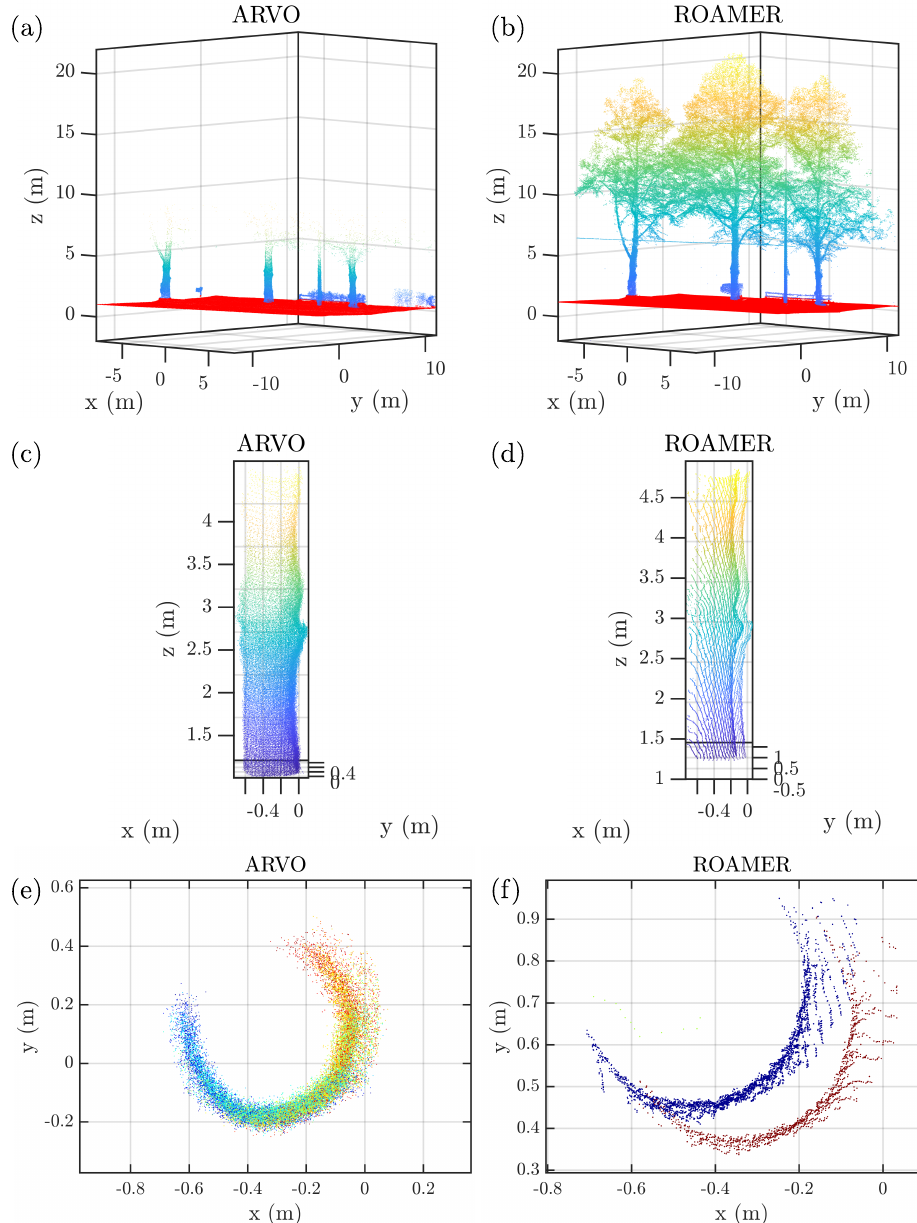
Figure 7. ( a , b ) A small section of the point cloud collected using ( a ) the ARVO system, and ( b ) the ROAMER system. The points are colored based on their z -coordinates, apart from the ground points that are denoted in red. ( c , d ) Close-up of an example tree trunk in the point cloud collected using ( c ) the ARVO system, and ( d ) the ROAMER system. Again, the points are colored based on their z -coordinates. ( e , f ) Cross-sectional view of the tree trunk illustrated in panels ( c , d ), respectively, when considering points from the height interval z ∈ [ 1.5,2.5 ] m. The points are colored based on the acquisition time of the data, such that the blue color denotes an earlier time and the red color denotes a later